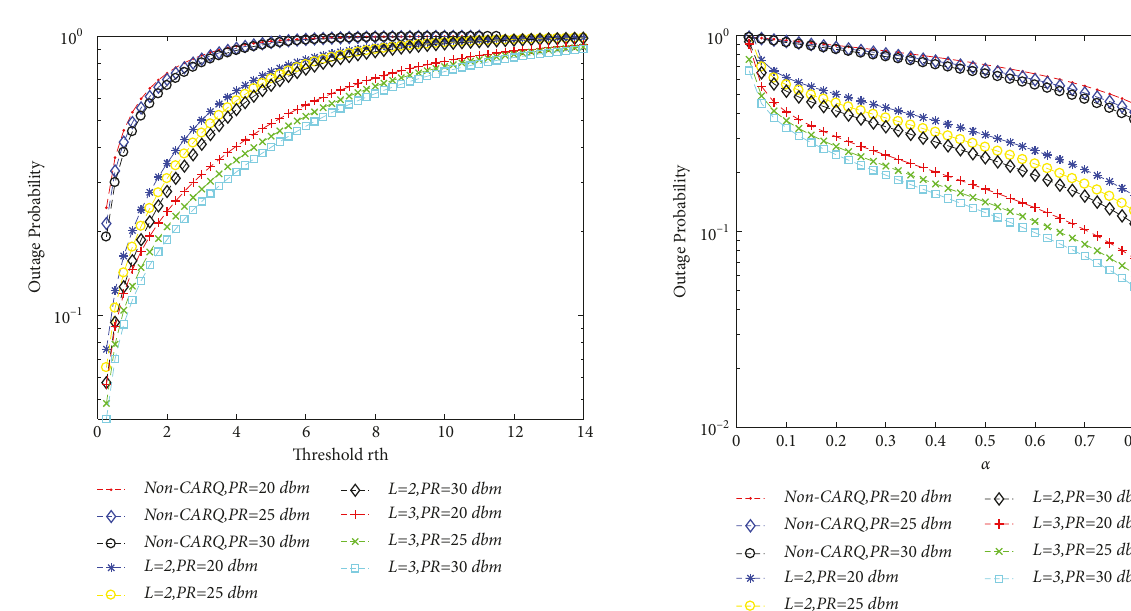
L and P R . Figure 6: α vs Pr